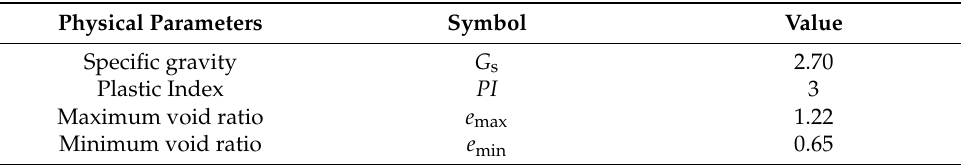
Figure 4. The grain size distribution of silt soil. Table 1. Physical properties of the silt soil tested in this study.